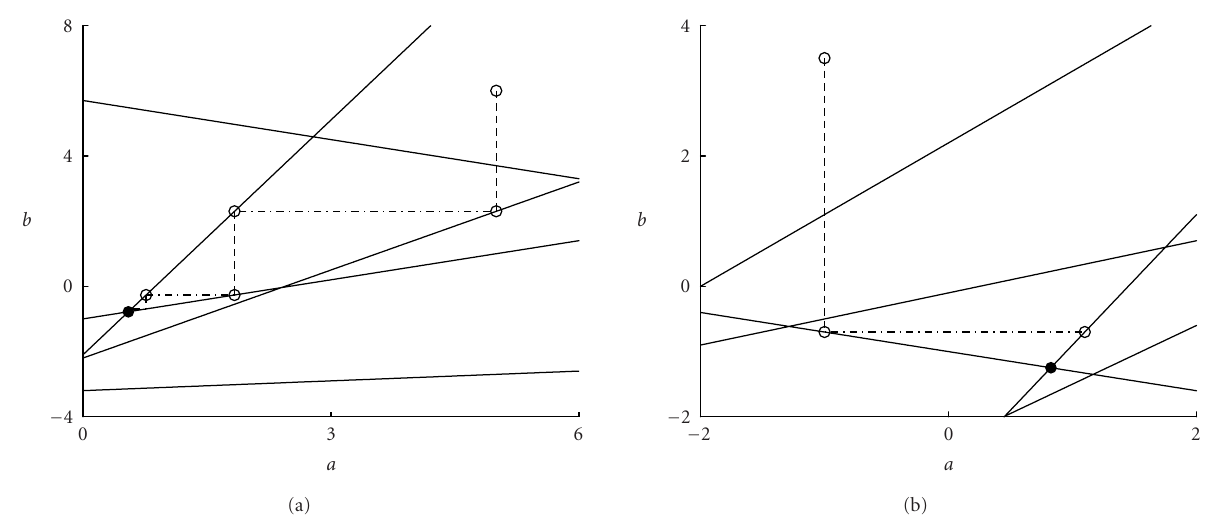
Figure 3: The parameters’ trajectories during the iterations. Vertical dashed lines represent b updates, while horizontal dotted lines represent a updates; (a) zigzag case, (b) nonoptimal case. The marked dots represent the global minima. To better illustrate, the initial values for a and b are not set from the LS